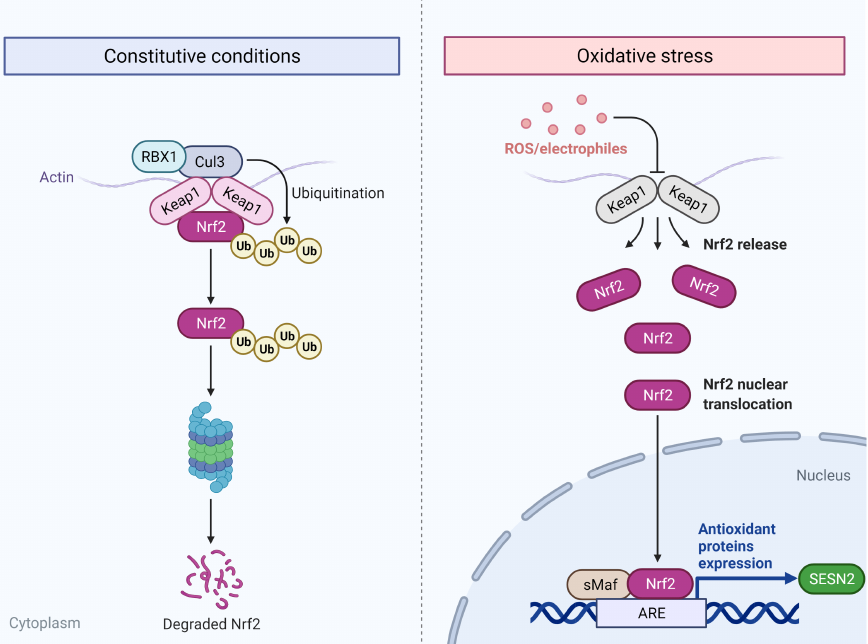
Figure 5. The regulation of SESN2 in response to oxidative stress. During constitute conditions, low levels of NRF2 are maintained due to ubiquitination mediated by KEAP-1 and proteasomal degradation of NRF2. ROS and electrophiles disrupt the binding of KEAP-1 with NRF2. NRF2 translocates to the nucleus and increases the expression of SESN2 by